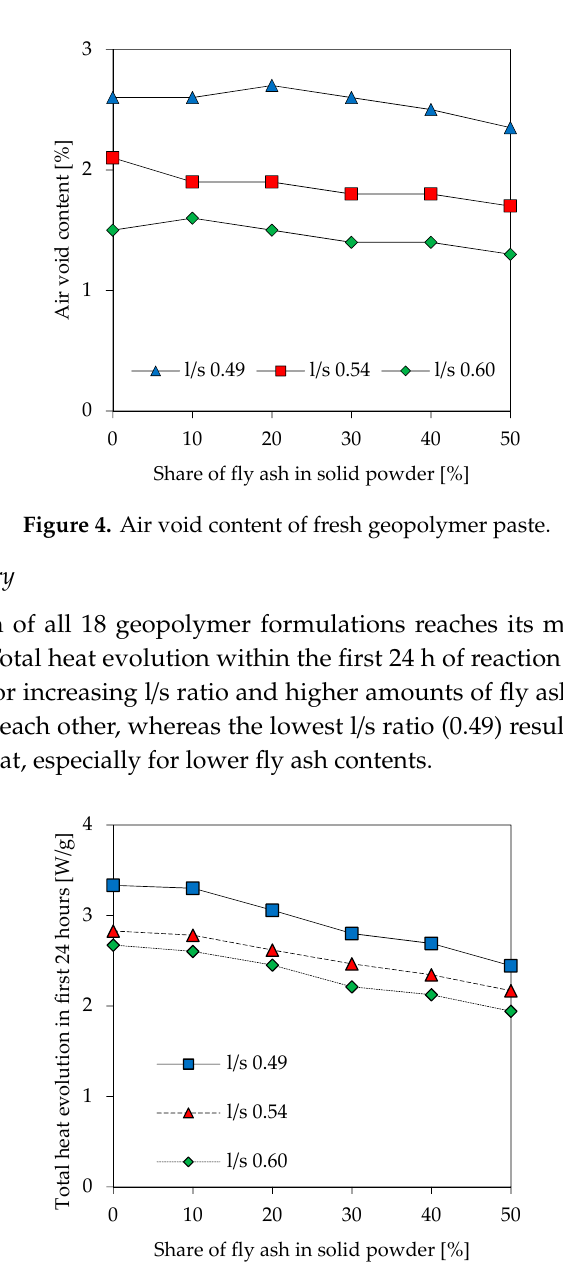
Figure 5. Total heat evolution of geopolymers in the first 24 h of reaction.